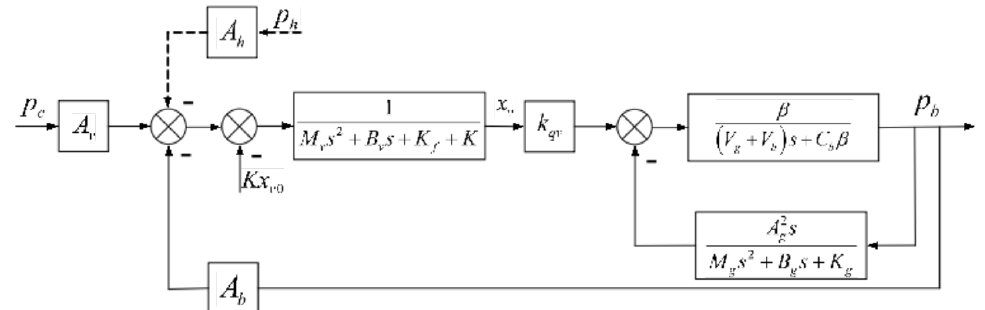
Figure 26. Bode diagram of the pre-stage.